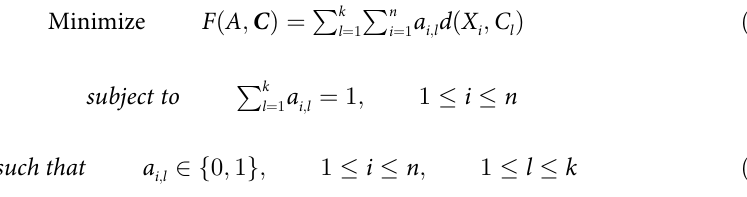
Algorithm 2 Pseudocode for Standard